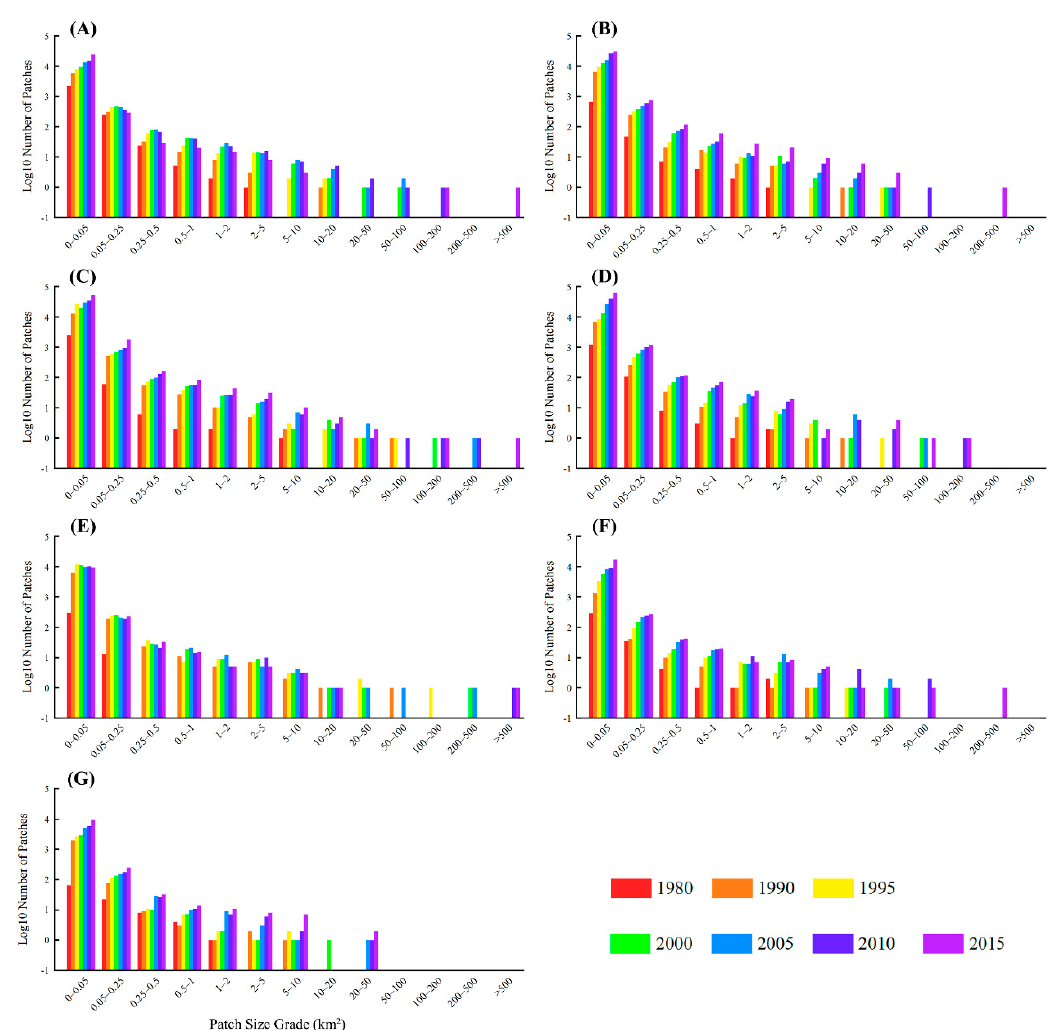
Figure 5. The frequency distribution of patch number in different grades of urban land patch size in seven cities from 1980 to 2015: ( A ) Dongguan, ( B ) Foshan, ( C ) Guangzhou, ( D ) Jiangmen, ( E ) Shenzhen, ( F ) Zhongshan, ( G ) Zhuhai. Dynamics of patch number at a given size, especially the smallest and largest size categories, could reveal temporal evolution of the urban land structure (e.g., diffusion–coalescence and urban core).